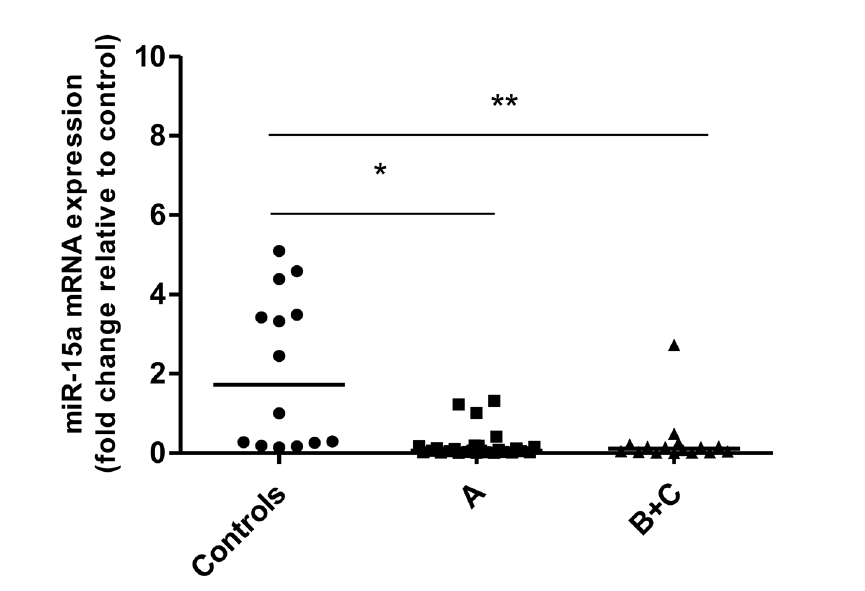
FIGURE 1 - miR-15a mRNA gene expression in the Controls, CLL Binet A (A) and Binet B+C (B+C). *p<0.001: A versus controls. **p<0.001: B+C versus controls. No significant difference was found when comparing Binet A and Binet B+C. Data was presented as median values generated by ANOVA, followed by the Kruskal-Wallis